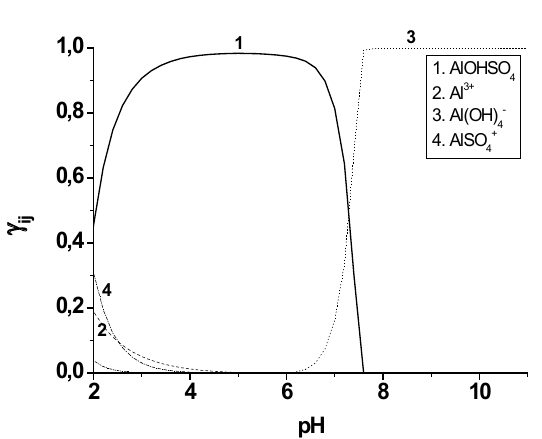
Diagrams of heterogeneous chemical equilibrium in the system “saturated aqueous solution – jurbanite”. Concentrations (mol L -1 ): 0 C Org